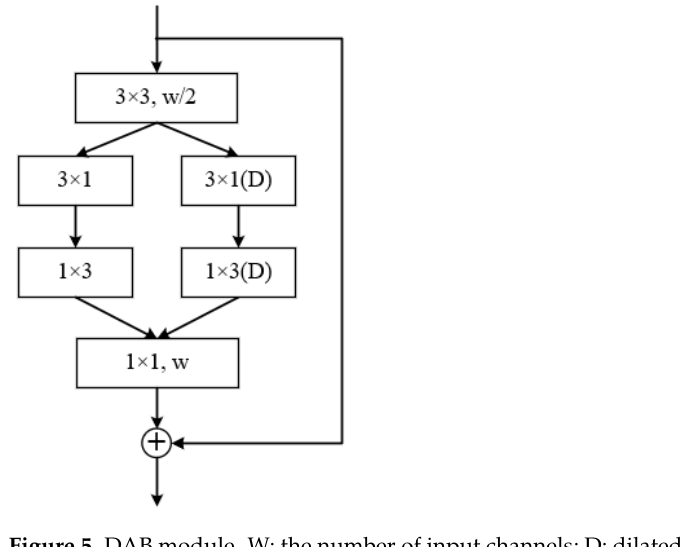
Figure 5. DAB module. W: the number of input channels; D: dilated convolution.